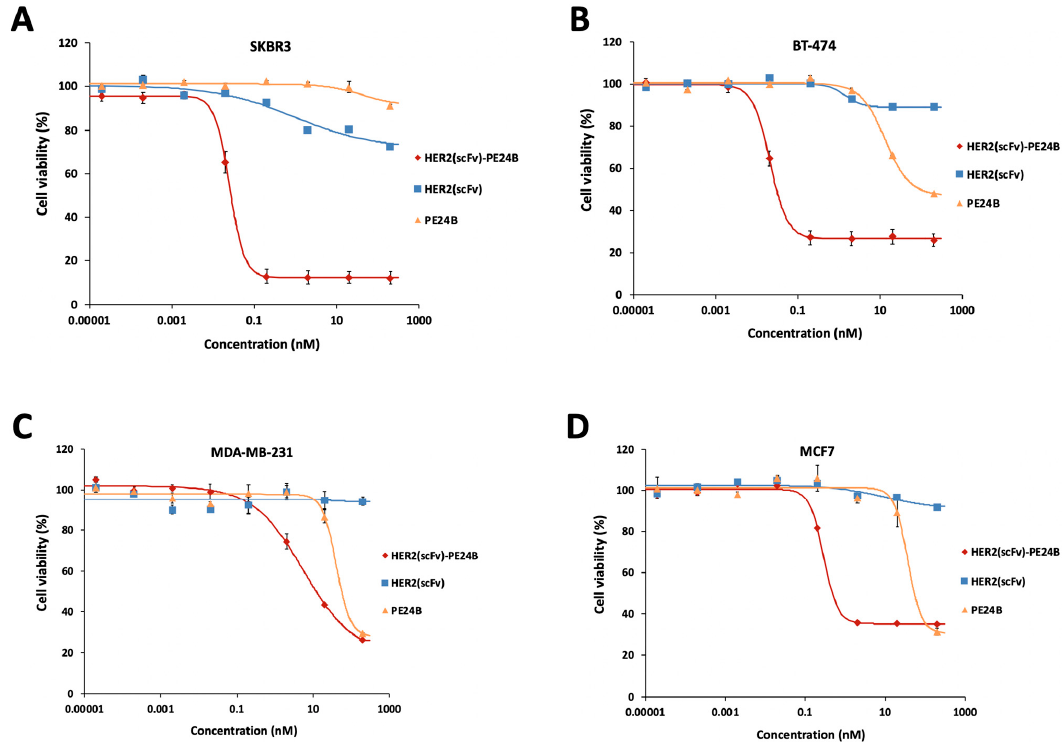
Figure 7. Cytotoxicity of HER2(scFv)-PE24B, HER2(scFv), and PE24B against high HER2-expressing and low HER2-expressing cell lines. HER2(scFv)-PE24B, HER2(scFv), and PE24B were added to high HER2-expressing cell lines SKBR3 ( A ) and BT-474 ( B ), and low HER2-expressing cell lines MCF7 ( C ) and MDA-MB-231 ( D ) for 72 h. For all cell lines, HER2(scFv)-PE24B showed stronger cytotoxicity than HER2(scFv) or PE24B alone. Untreated cells served as controls. Cell viability was determined from at least three independent MTT assay experiments and calculated as the absorbance ratio of treatment vs. control groups. Data are presented as mean ± standard error (SE).